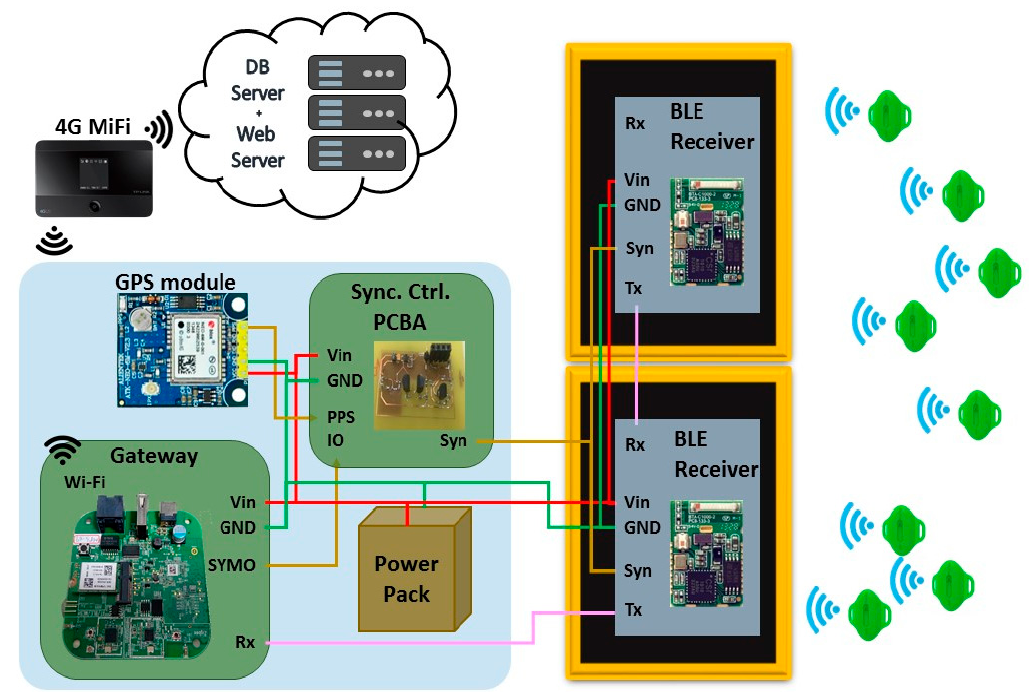
Figure 8. The Gateway, global positioning system (GPS), and synchronization control board connected to the BLE Receivers. PCBA, Printed Circuit Board Assembly; GND, ground; PPS, pulse-per-second; IO, input output; SYMO, synchronous mask output.